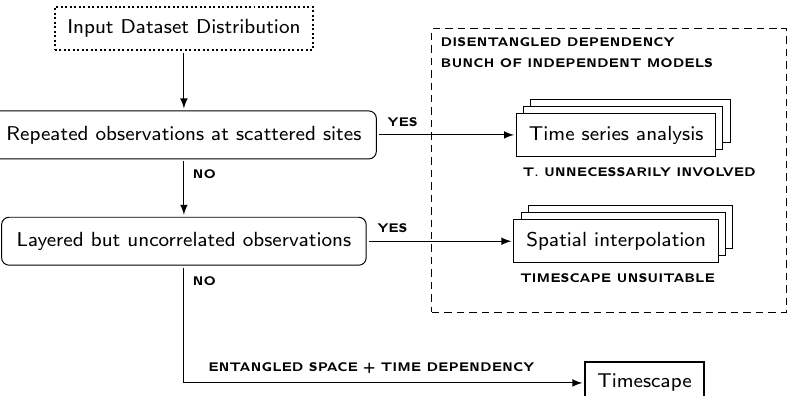
Figure 21. An input-driven decision tree. The extreme cases (purely spatial and purely temporal dependencies, see Table 5) suggest that the Timescape algorithm is either unsuitable or far too involved, and the entangled cases can be advantageously